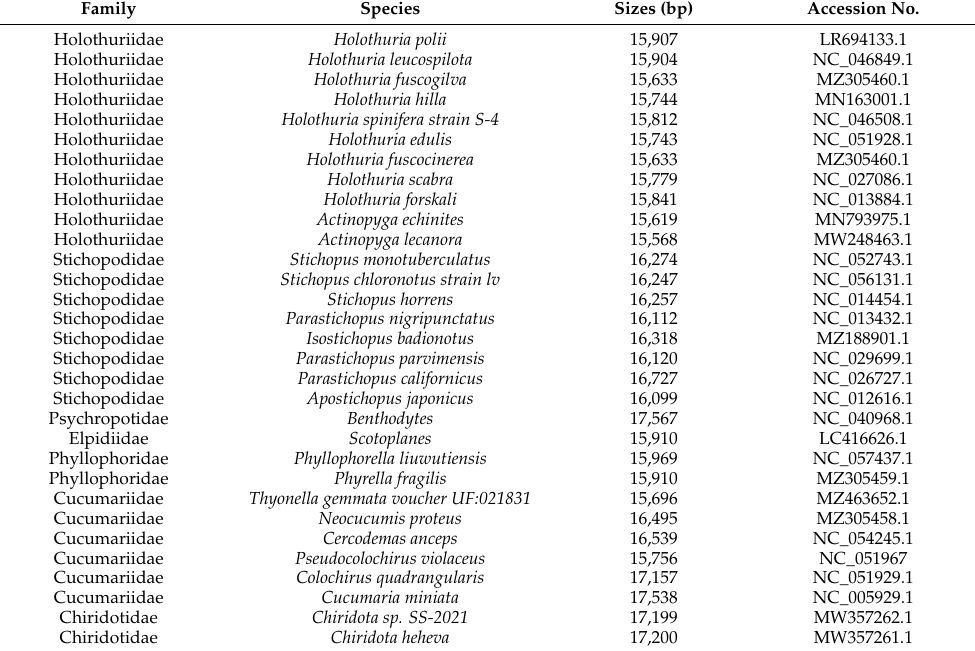
Table 1. Mitogenomes of sea cucumbers used for the phylogenetic analysis in this